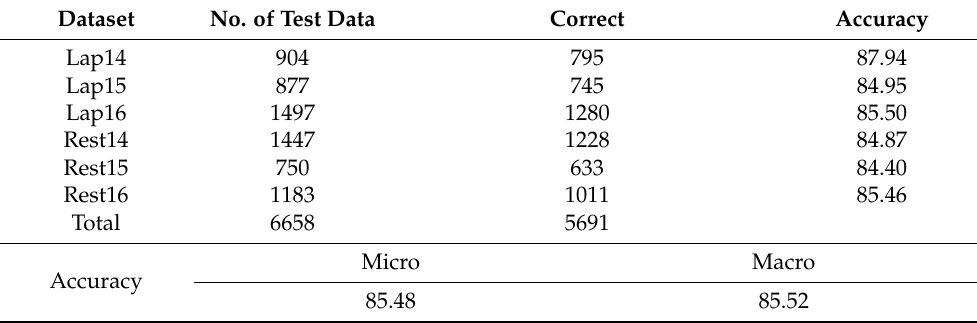
Table 4. Performance for target extraction (Task 2).